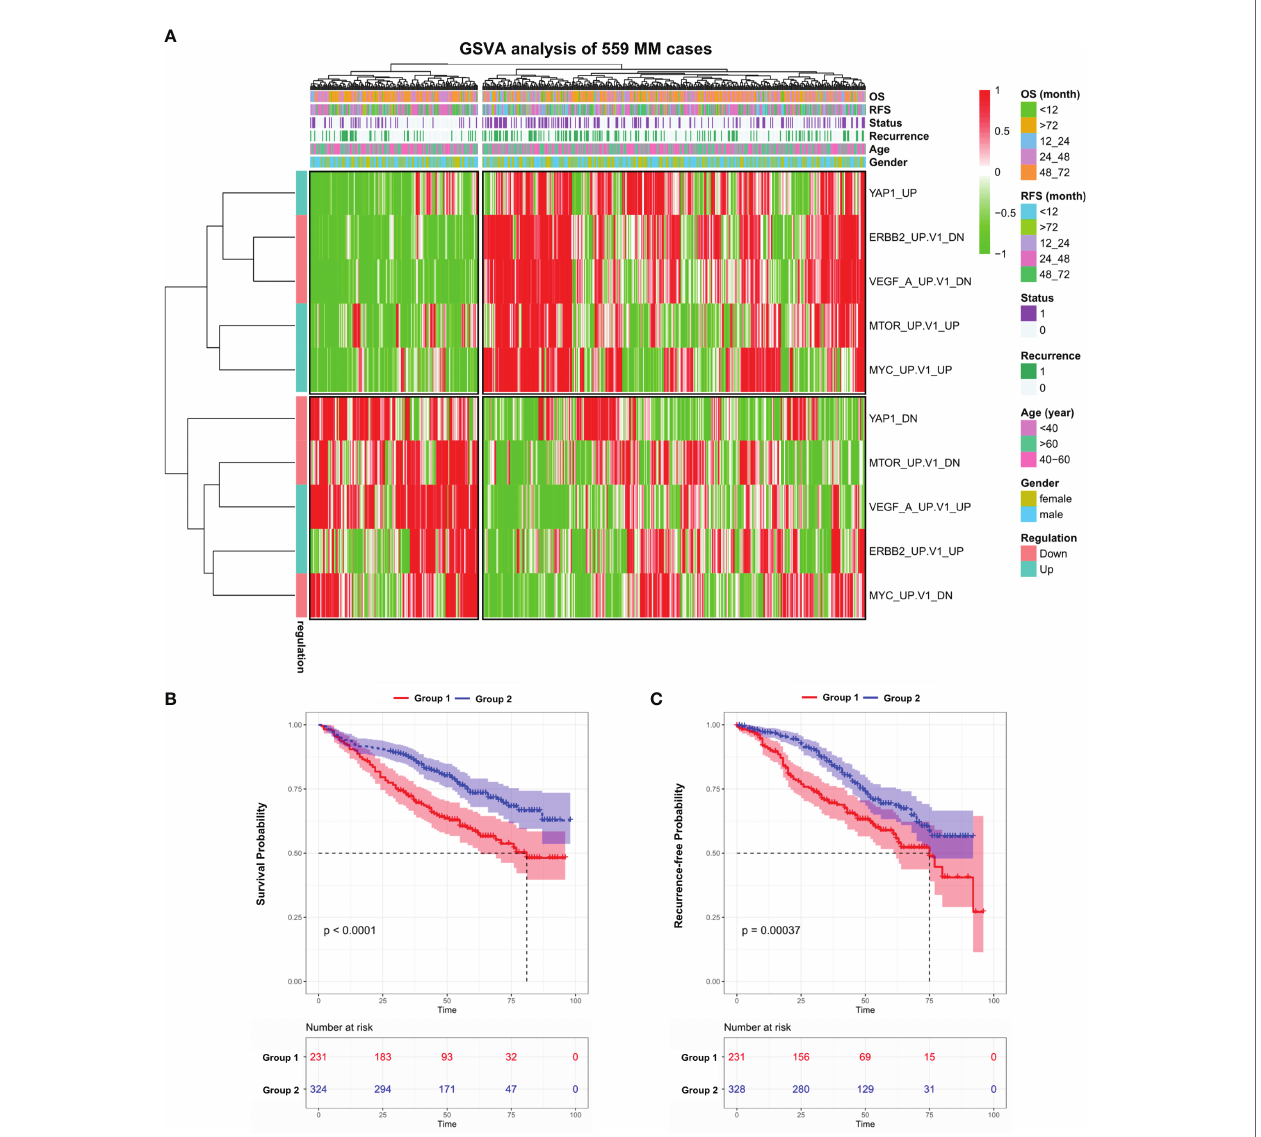
FIGURE 1 | Gene set variation analysis of 559 newly diagnosed MM cases. (A) Heatmap of gene set variation analysis (GSVA) of 559 Multiple Myeloma transcriptome data (GSE24080) based on 10 selected C6-oncogenic signature gene sets from Molecular Signature Database. The relevant clinical information was added above. (B) Kaplan – Meier survival curves comparing the overall survival in MM group 1 and 2 from the GSE24080 dataset. (C) Kaplan – Meier survival curves comparing the recurrence-free survival in MM group 1 and 2 from the GSE24080 dataset. Results are shown as mean ± CI based on the log-rank t